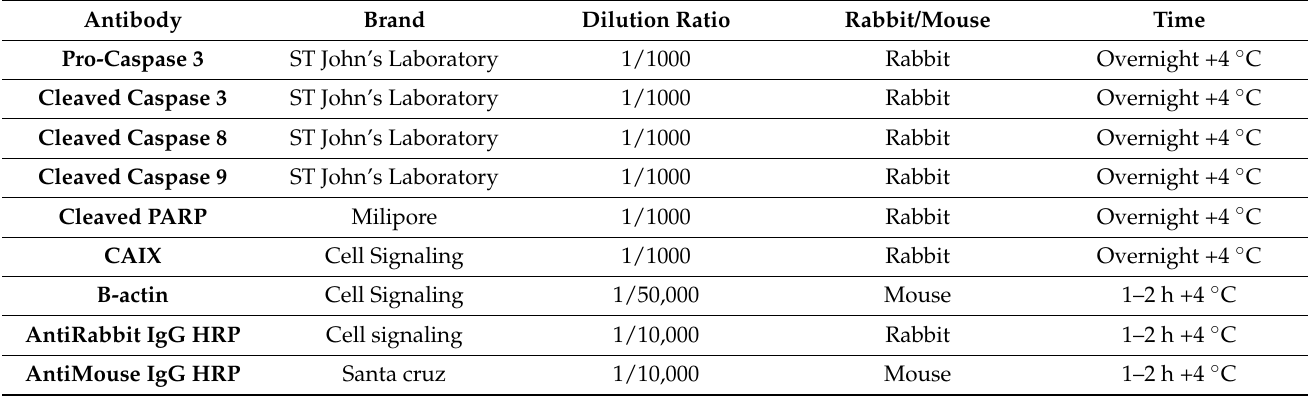
Table 3. Primer monoclonal antibodies and seconder antibodies used for the Western